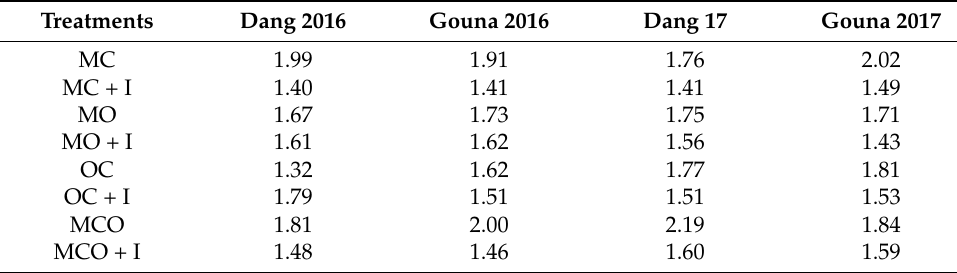
Table 6. Land equivalent ratio at Dang and